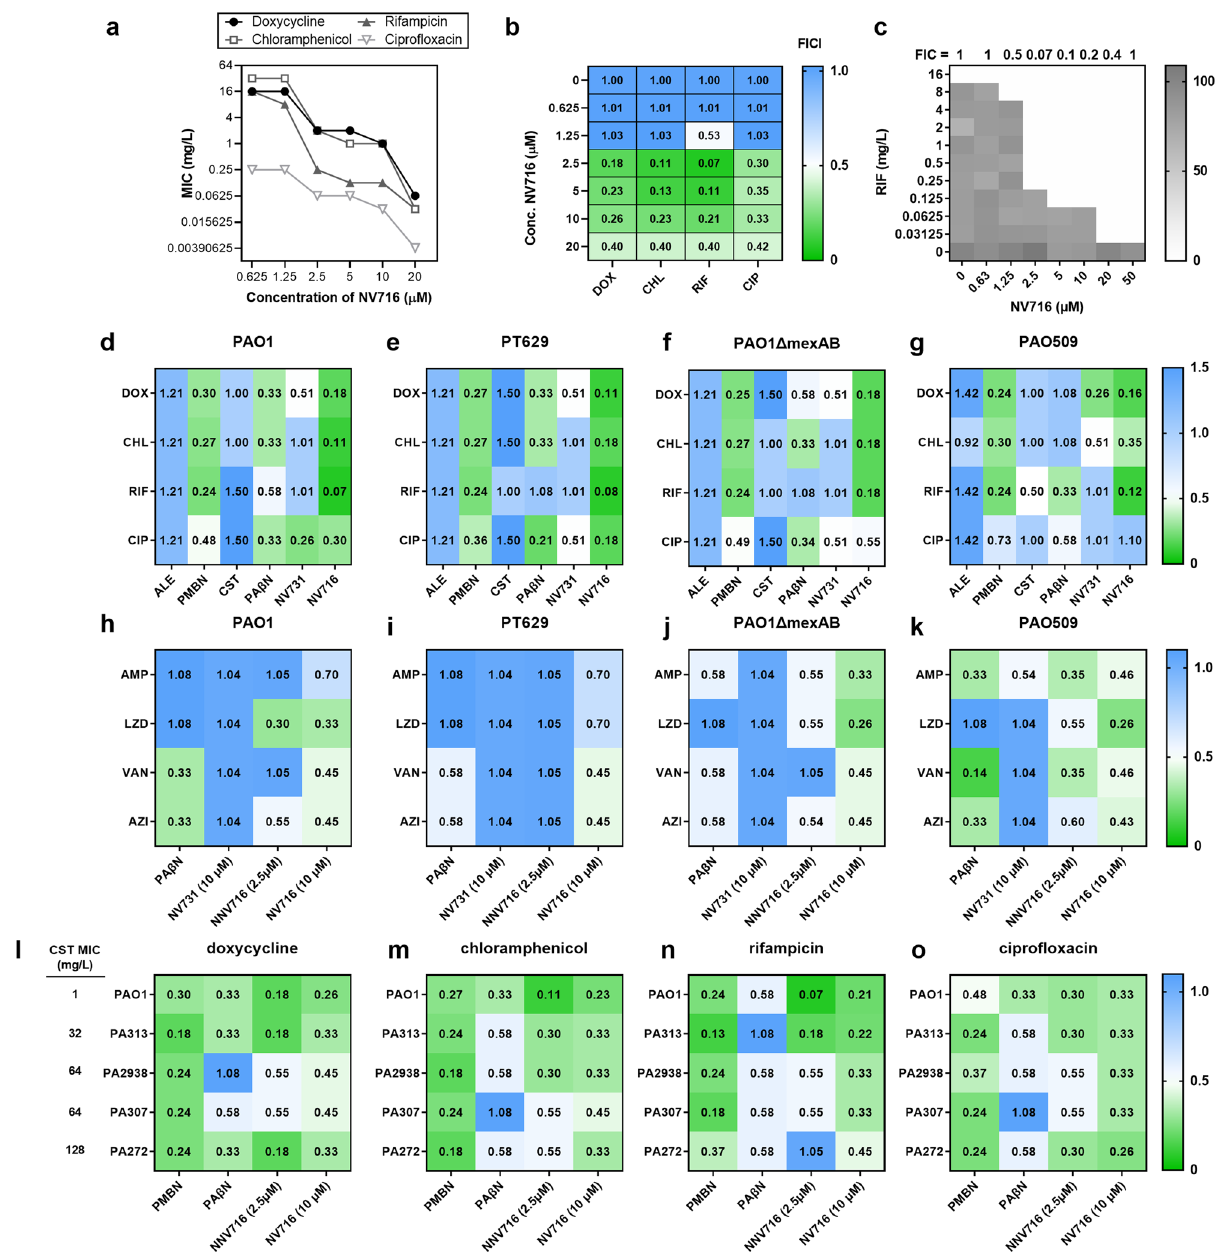
Fig. 1 Checkerboard analyses for the evaluation of the synergy between potentiators and antibiotics. a – c Detailed analysis for PAO1. a Change in the MICs of 4 antibiotics in the presence of NV716 at increasing concentrations. b Determination of the corresponding FIC indexes (FICI) in a heatmap plot. c Checkerboard plate having allowed to determine FICI for the combination of NV716 and rifampicin. The gray scale shows the A 620 nm in percentage of the maximal value. The other panels show heatmaps describing FICI of potentiators for reference strains in combination with ( d – g ) abandoned antibiotics (DOX doxycycline, CHL chloramphenicol, RIF rifampicin) and cipro fl oxacin (CIP), calculated for concentrations of 2.5 μ M alexidine, 0.5 µ M colistin (CST), 30 µ M PMBN, 38 µ M PA β N, 2.5 μ M NV731 and 2.5 μ M NV716; or with ( h – k ) ampicillin (AMP) or antibiotics active against Gram-positive bacteria (LZD linezolid, VAN vancomycin, AZI azithromycin), calculated for concentrations of 38 µ M PA β N, 2.5 μ M NV731, 2.5 mM and 10 μ M NV716; or for 4 colistin- resistant isolates 25 vs . PAO1 ( l – o , with colistin MICs are shown on the left) combined with the same antibiotics as in d – g and calculated for concentrations of 38 µ M PA β N, 30 µ M PMBN, or 2.5 or 10 µ M NV716. Synergy is de fi ned as FICI < 0.5 (appearing in green on the graphs). All data are mean from at least two independent experiments. PT629: MexAB overproducer derivative of PAO1; PAO1 mexAB : PAO1 derivative deleted for the expression of